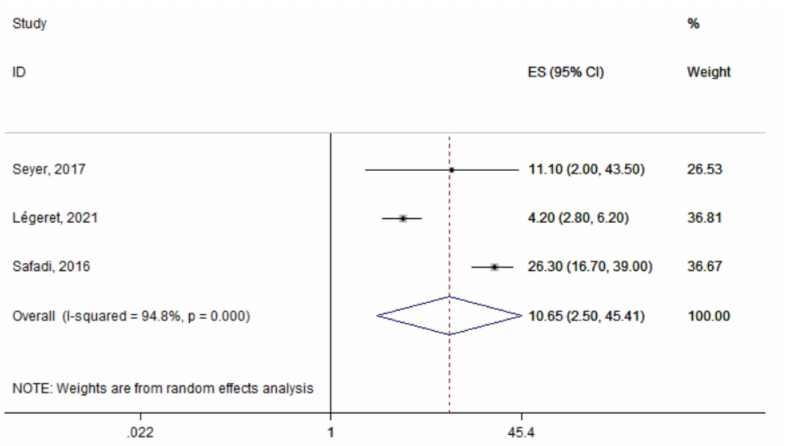
Figure 3. Forest plot of the summary prevalence of Blastocystis hominis infections in children residing in Europe (2015–2021). Prevalence ratios of individual studies are indicated by the data markers; shaded boxes around data markers reflect the statistical weight of the study; 95% confidence intervals (CI) are indicated by the error bars; summary-effect estimates with their 95% CI are depicted as a